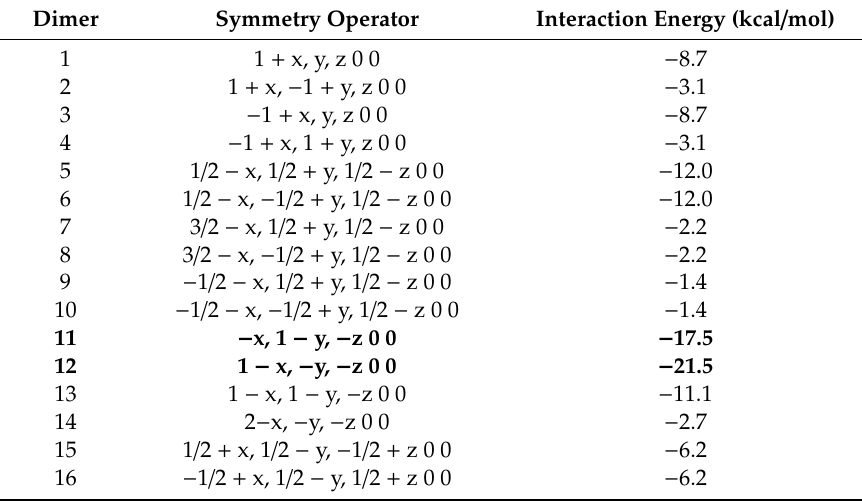
Table 2. Numbering of dimers, symmetry operation of second molecule of dimer and corresponding intermolecular interaction energy of dimers formed by the basic molecule in the crystals (dimers showing the strongest interaction are highlighted in